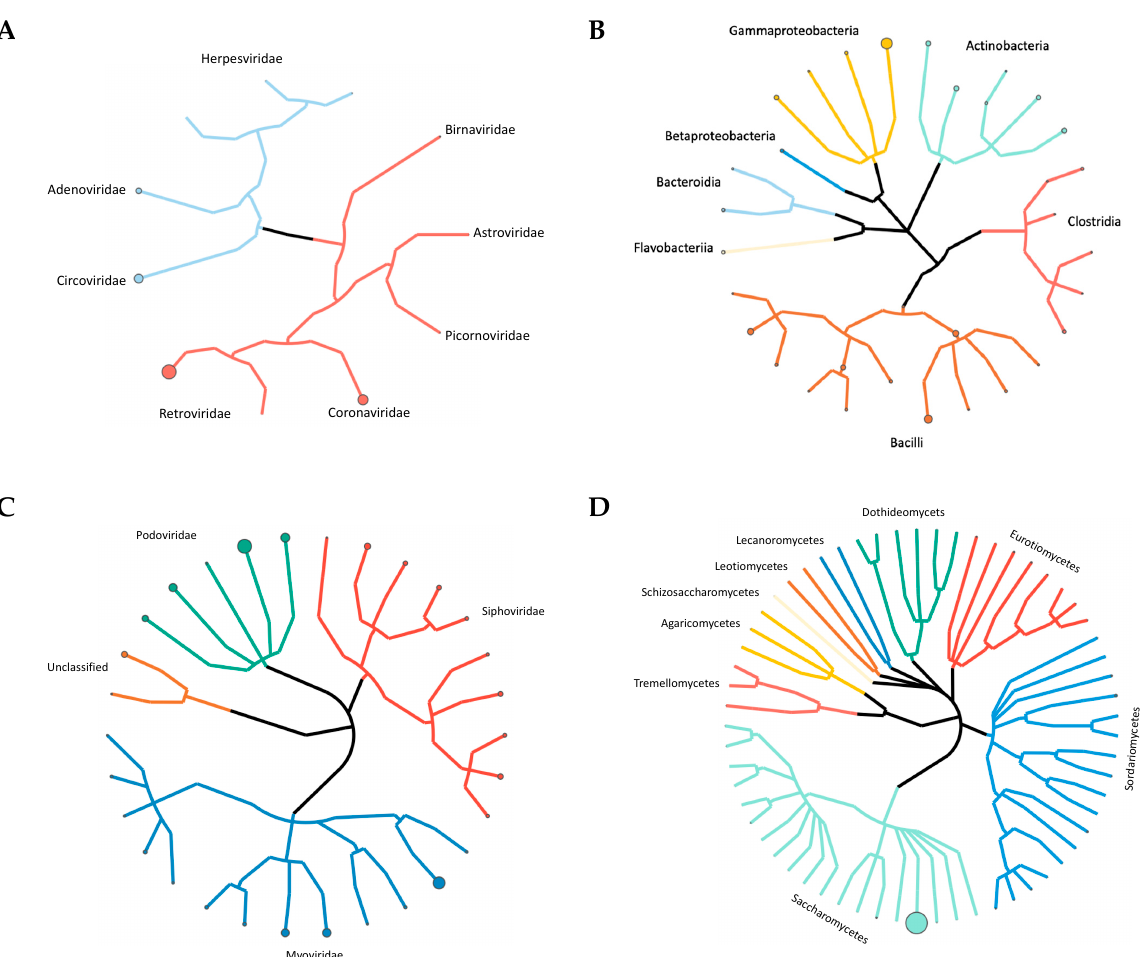
Figure 4. Abundance of ( A ) virus, ( B ) bacteria, ( C ) bacteriophage and ( D ) fungi at Week 0, Week 1 and Week 7. Taxa represented at family ( A , C ) and phylum ( B , D ) level.